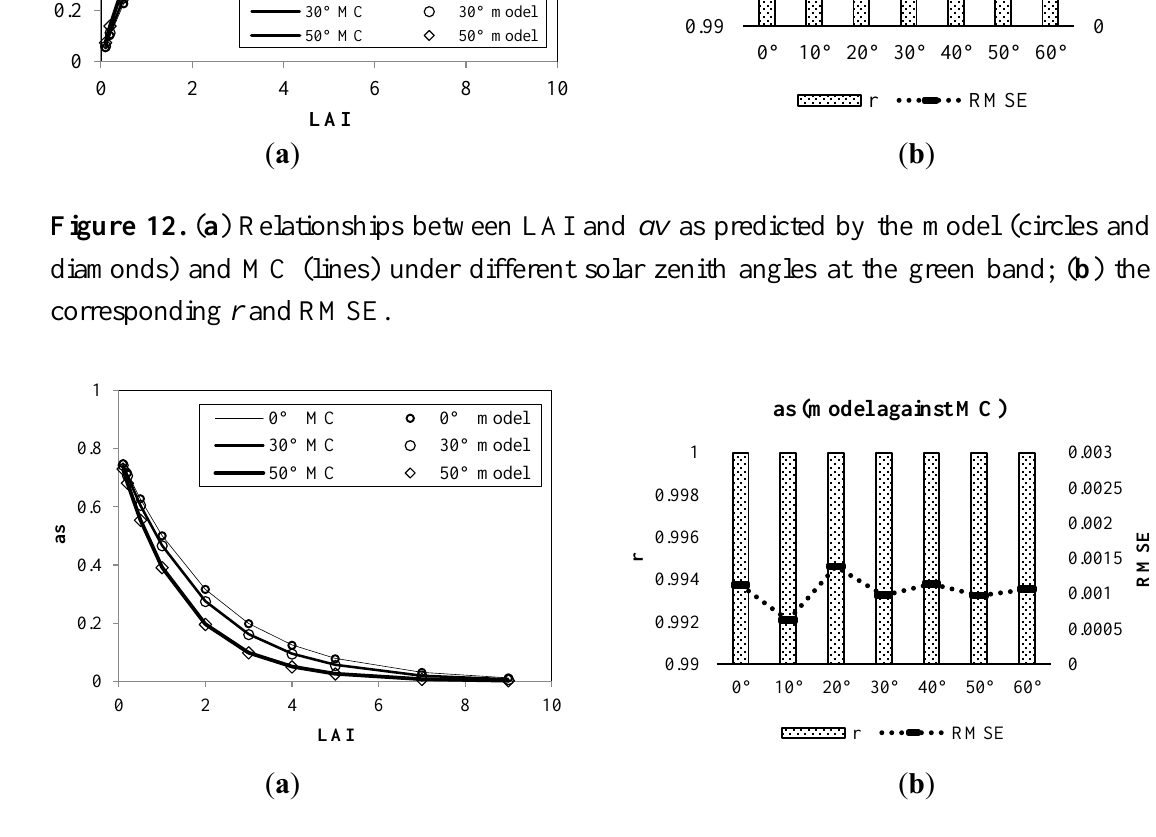
Figure 13. ( a ) Relationships between LAI and as as predicted by the model (circles and diamonds) and MC (lines) under different solar zenith angles at the green band; ( b ) the corresponding r and